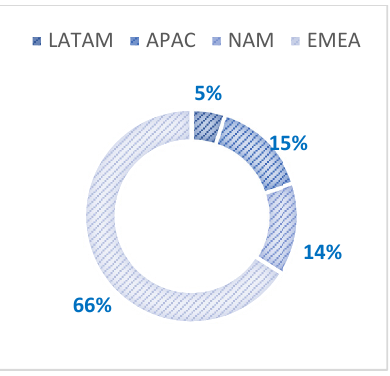
Figure 5. Global Bond Issuance Volumes, YTD 2021, Breakdown by Geography (Janse and Bradford 2021).